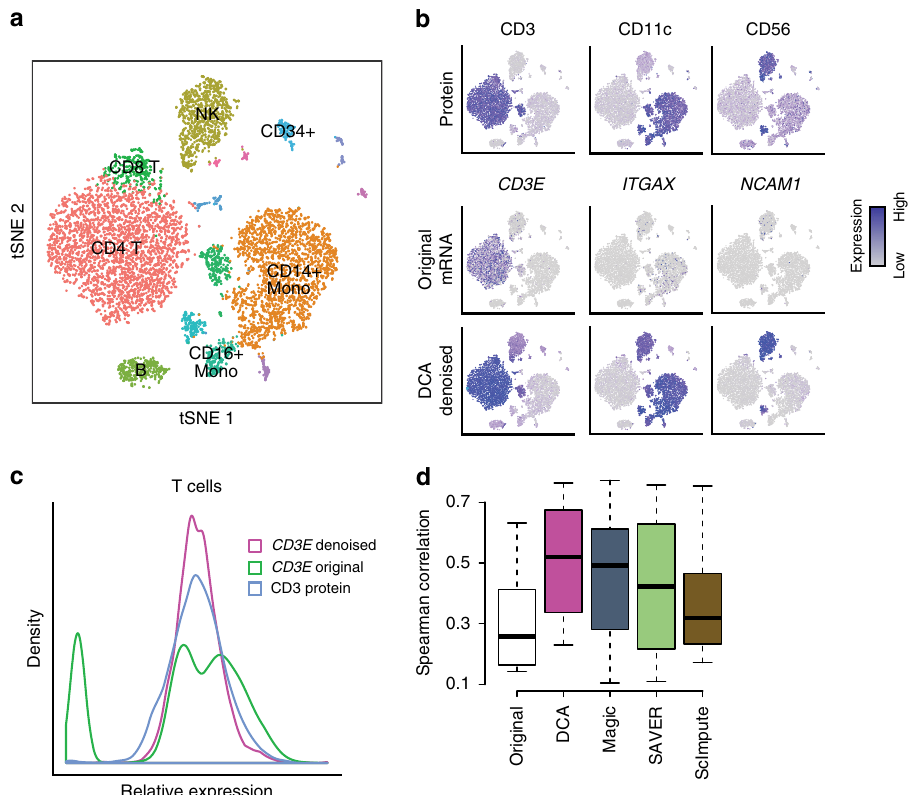
Fig. 6 DCA increases protein and RNA co-expression. a depicts tSNE visualization of transcriptomic pro fi les of cord blood mononuclear cells from Stoeckius et al. 43 . Cells are colored by major immunological celltypes. b contains tSNE visualizations colored by protein expression ( fi rst row), RNA expression derived from the original (second row) and DCA denoised data (third row). Columns correspond to CD3 ( fi rst column), CD11c (second column), CD56 (third column) proteins and corresponding RNAs CD3E, ITGAX and NCAM1. c shows the distribution of expression values for CD3 protein (blue), original (green) and DCA denoised (pink) CD3E RNA in T cells. Spearman correlation coef fi cients for the eight protein-RNA pairs across all cells for the original and denoised data are plotted in